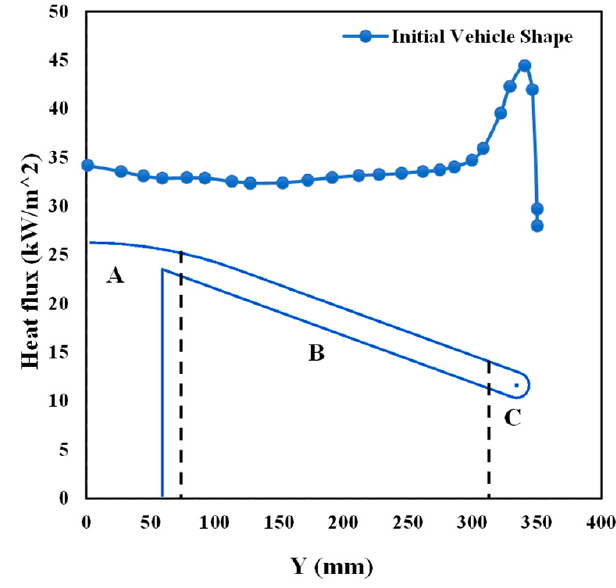
Figure 9. Heat flux distribution of initial shape. Figure 9. Heat fl ux distribution of initial shape.